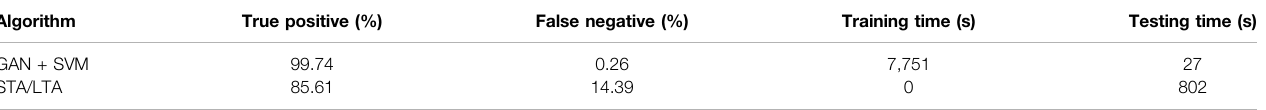
TABLE 5 | Comparison of the results with the STA/LTA method.